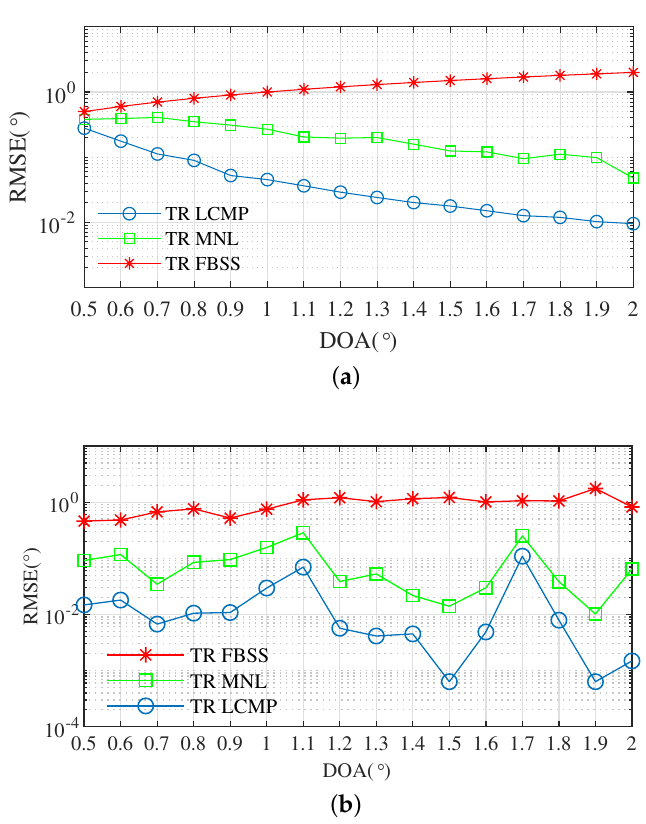
Figure 4. RMSE of the three algorithms for different DOAs under SNR = 10 dB. ( a ) Different DOAs with the same diffuse multipath; ( b ) Different DOAs with different diffuse